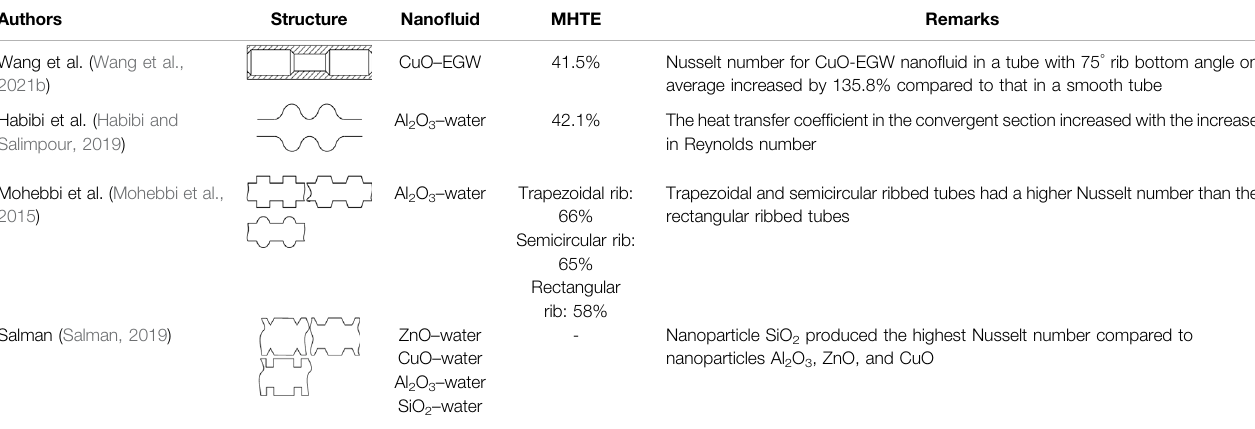
TABLE 7 | Thermal performance of nano fl uids in tubes with various ribbed